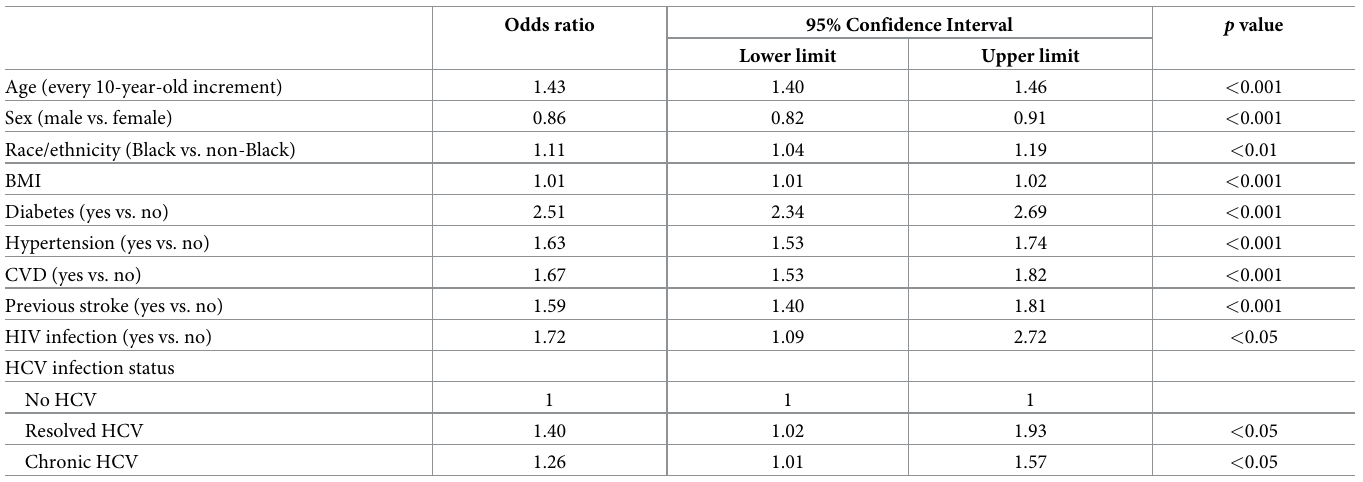
Table 2. Risk factors of kidney disease among total population by multivariable logistic regression. Odds ratio 95% Confidence Interval p value Lower limit Upper